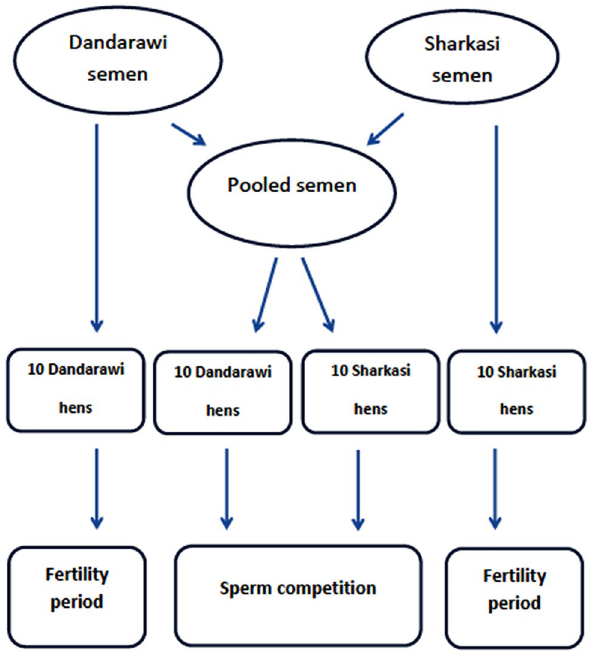
Figure 6. A diagram demonstrating the experiment design. For assessing sperm competition, Dandarawi and Sharkasi hens were inseminated 10 consecutive times (with 3 days intervals between each two consecutive inseminations) by semen-pooled ejaculates collected from both breeds so that each inseminated semen pool contained an equal number of sperm from both strains. To evaluate fertility duration, Dandarawi and Sharkasi hens were inseminated using semen collected from roosters of the same breed. Eggs were collected for a period of 28 days and set into the